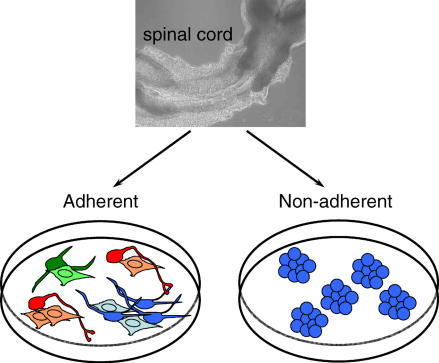
Spinal Cord Progenitors Isolated from the Cord and Grown in Tissue Culture as Adherent Cultures or Nonadherent NanospheresMore heterogeneity is seen after adherent culture compared to neurosphere culture.